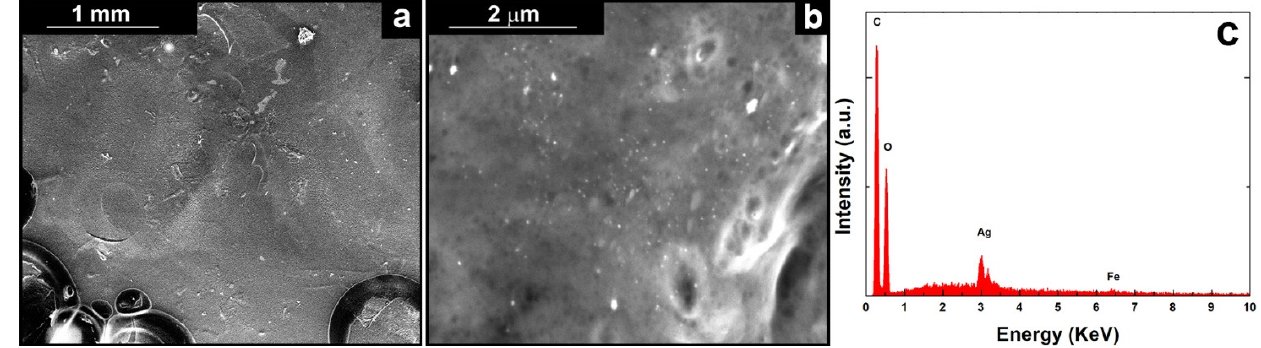
Figure 3. ( a ) Low, ( b ) high magnification SEM images and ( c ) relative EDS spectrum of the coating obtained using a solution of 10gL − 1 of CS.